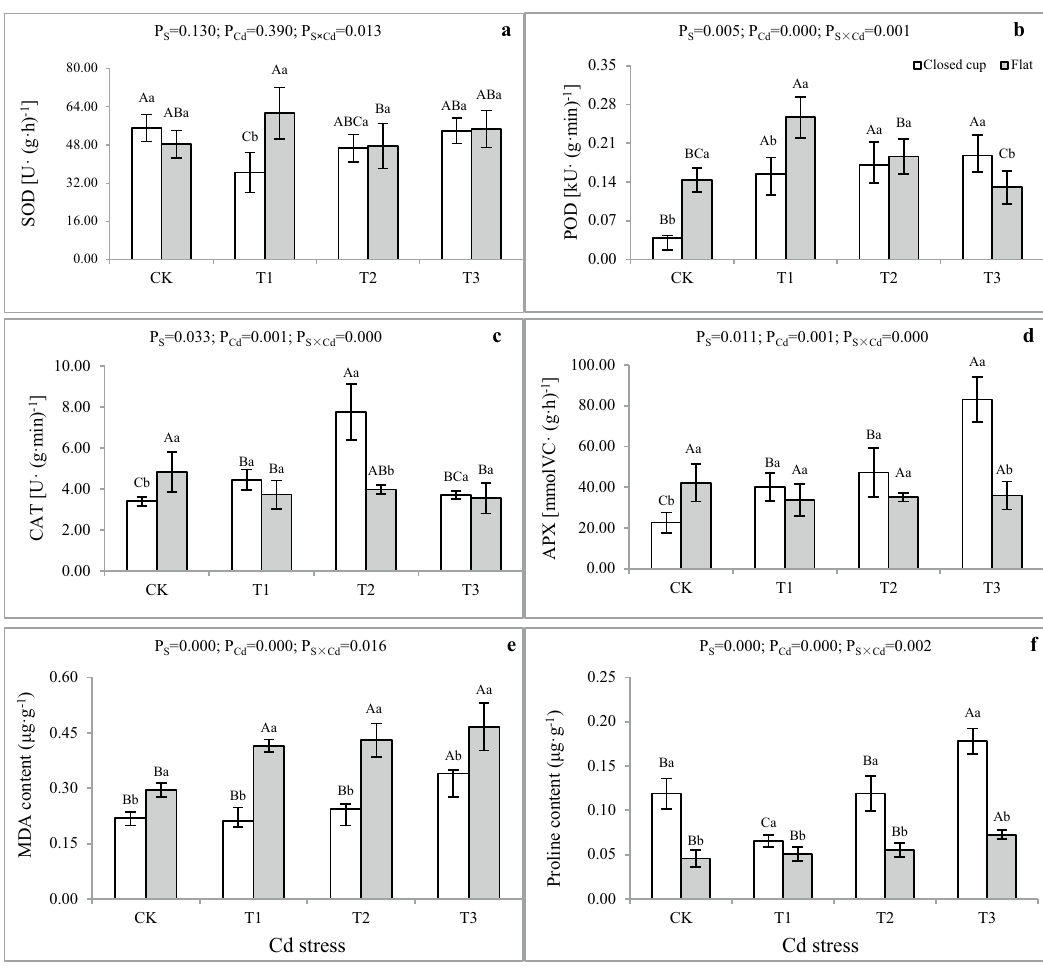
Figure 3. Effect of Cd on the activities of SOD, POD, CAT, and APX, and the content MDA and free proline in the fruiting bodies of A. bisporus . ( a ) SOD activity. ( b ) POD activity. ( c ) CAT activity. ( d ) APX activity. ( e ) MDA content. ( f ) Proline content. Different capital letters indicate significant differences among Cd stresses under the same sampling stage determined by LSD’s test with p < 0.05; different lower letters indicate significant differences within the sampling stage under the same Cd stress concentration determined by LSD’s test with p < 0.05. P S : effect of sampling time; P Cd : effect of Cd concentration; P S×Cd : Interaction between sampling time and Cd concentration. Error bar: